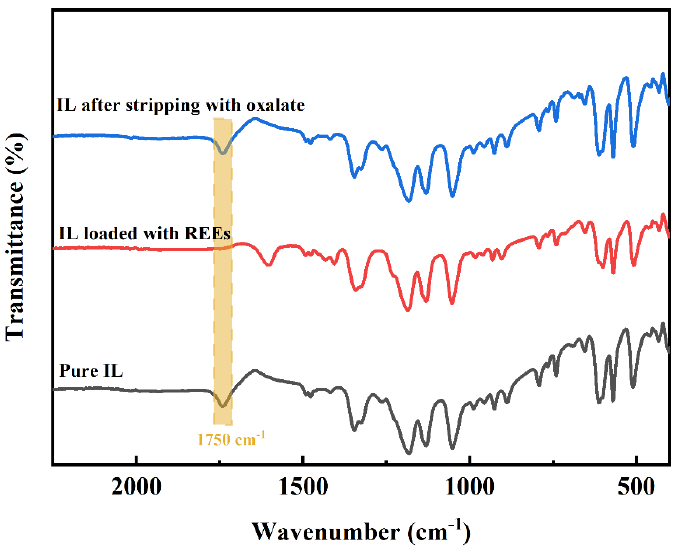
Figure 11. FTIR curves of pure IL, IL loaded with REE, and IL after back extraction with oxalic acid solution.